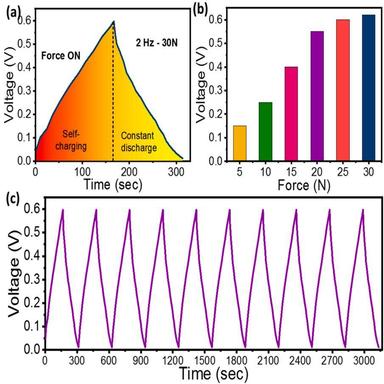
(a)Self-charging profile of the snake ecdysis -rGO based piezo-electric supercapacitor under an applied compressive force (30 N). (b) Comparison of the charging of the piezo-supercapacitor under various applied compressive forces. (c) Repetitive cycling stability of the self-charging trend of the device under constant compressive force (2 Hz, 30 N).